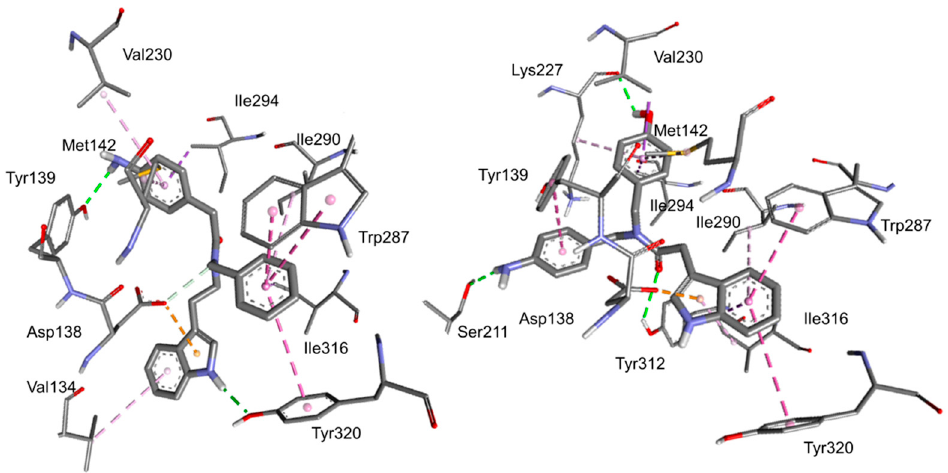
Figure 3. Side views of the predicted binding modes for peptides 2 ( left ) and 5 ( right ) to the deposited structure of κ -OR (PDB ID: 4DJH). The relevant receptor residue side chains are rendered in thick lines and the ligands in sticks; C is rendered in grey, N in blue, and O in red. Dashed green lines represent conventional hydrogen bonds, while cation–pi interactions are rendered in yellow, pi–pi interactions in violet, hydrophobic interactions in white, and other interactions in pink. The interactions have been analyzed with Discovery Studio 2016 and with PacDOCK web server.